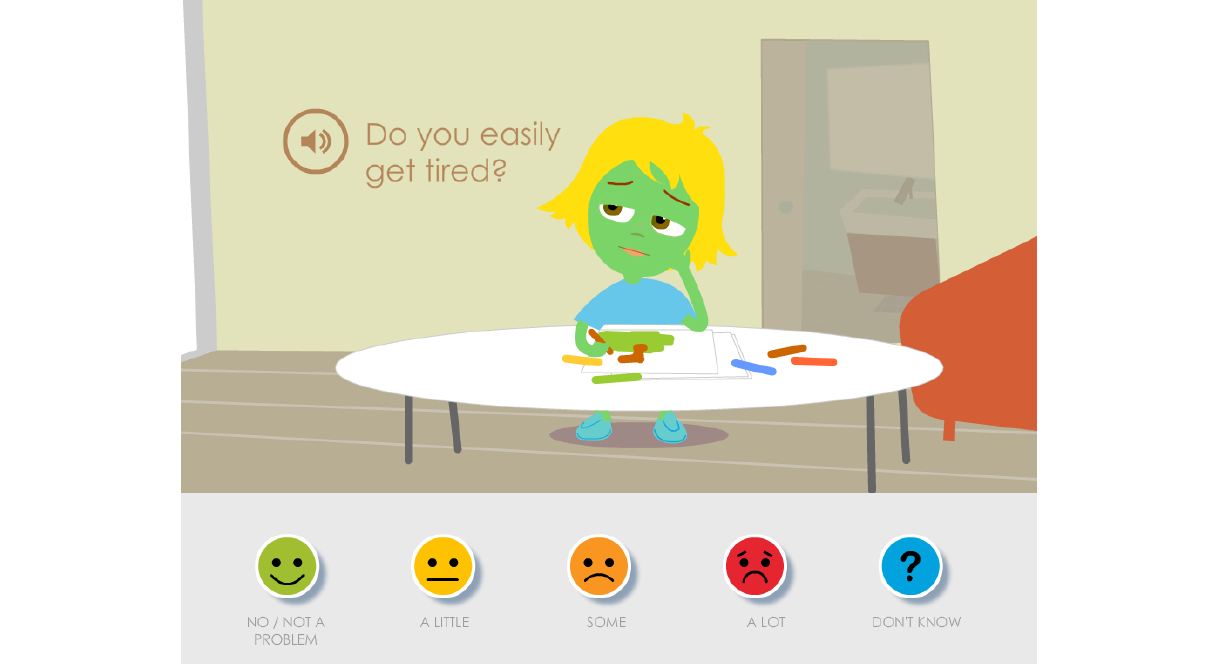
Figure 7. This picture shows the refinements based on the children and parents’suggestions to change the open mouth of the red smiley to a more sad